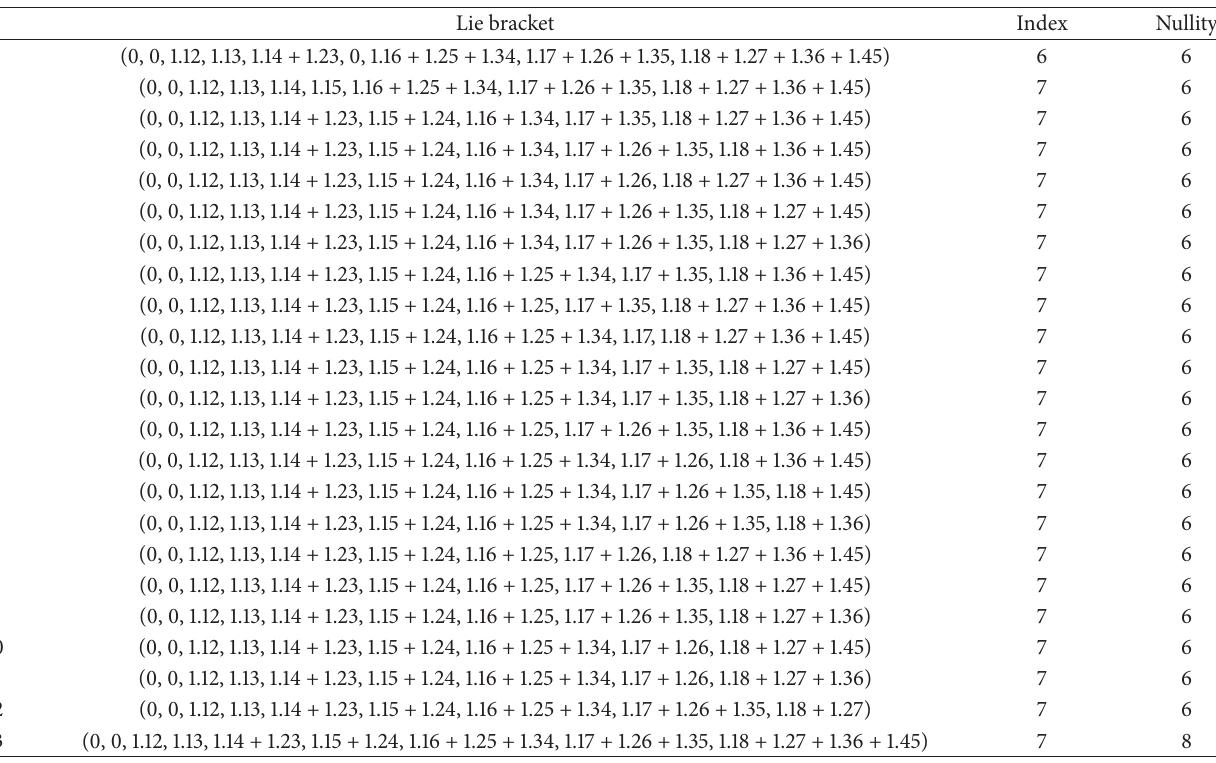
Table 6: The 9-dimensional candidates of nullities 6 and